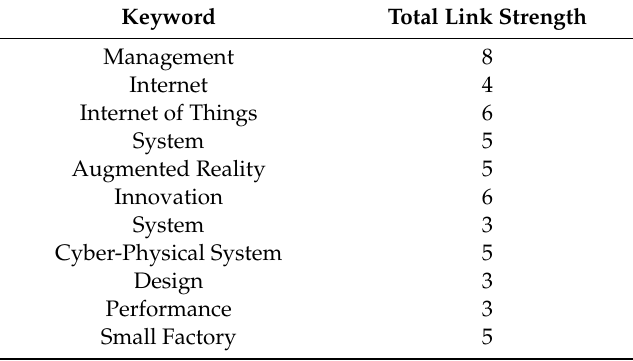
Table 7. Total link strength of keyword Industry 4.0 with its linked keywords in Web of Science. Keyword